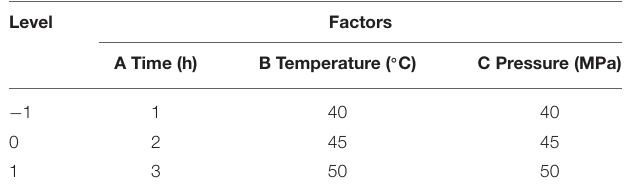
TABLE 1 | The factor and level of response surface methodology in the extraction of Moringa seed oil by supercritical CO 2 .